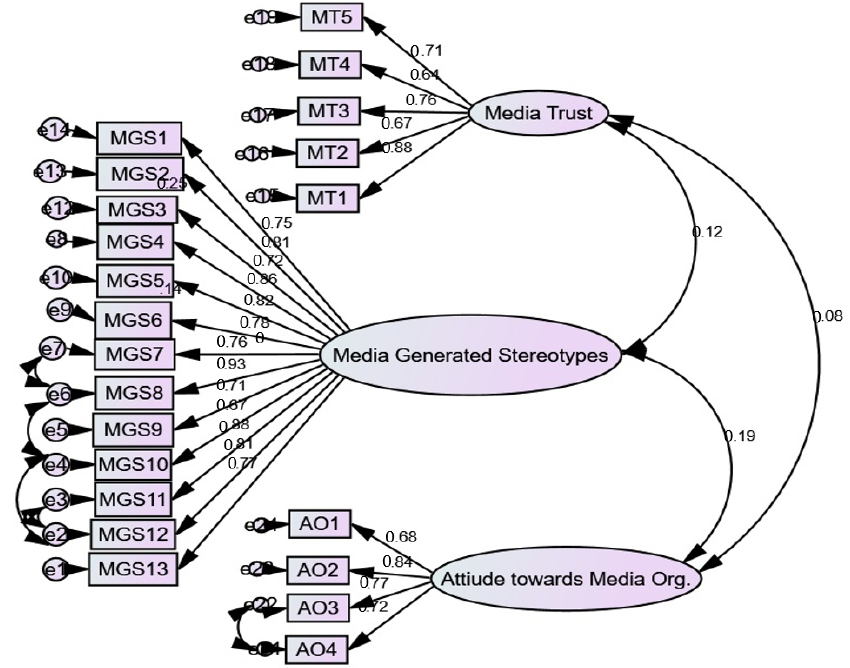
Figure 1. Measurement Model with item-loadings on parent factors of MGS, AO, and MT.